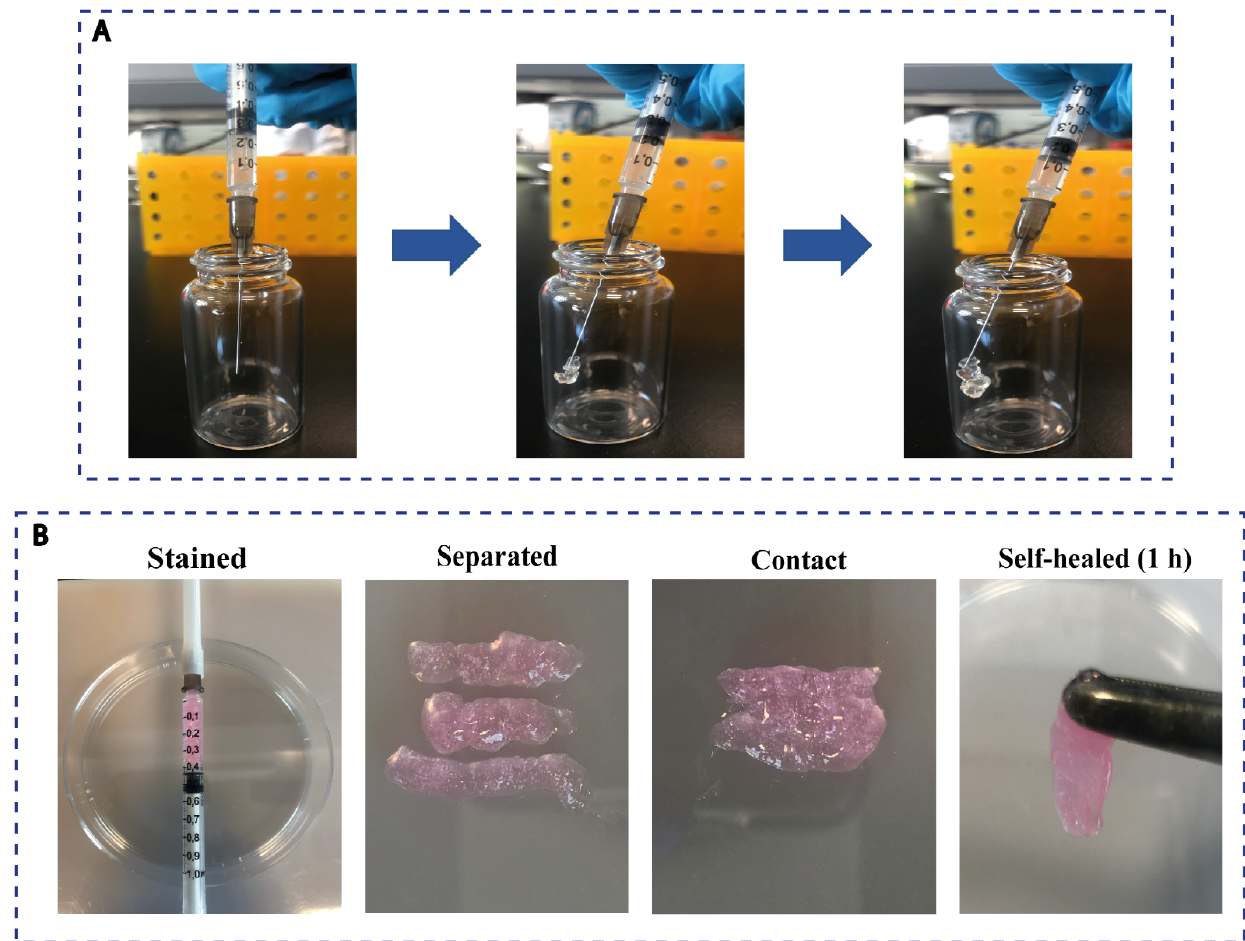
Figure 3. ( A ) Injectable property of CTS/CTS–CHO hydrogels. ( B ) Self-healable property of stained hydrogels.